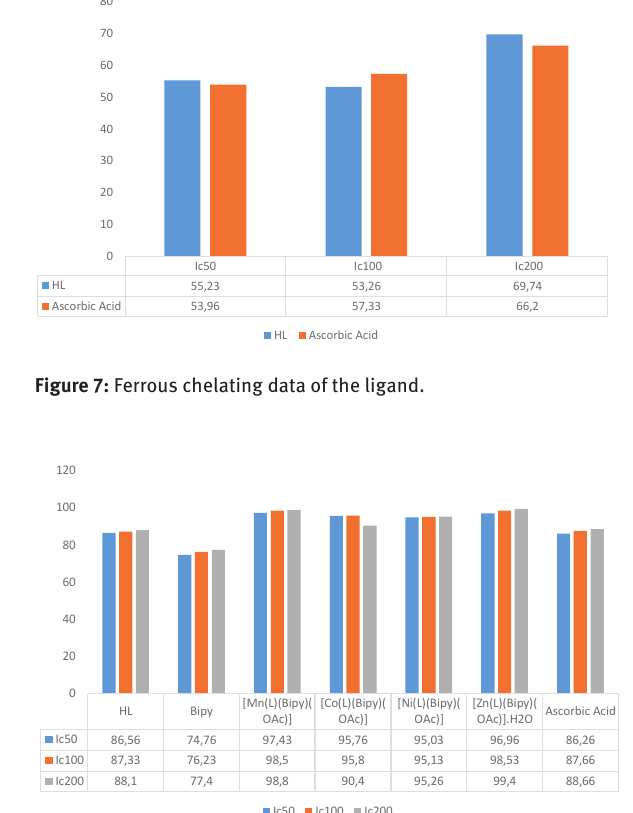
Table 6: Free binding energy(kcal/mol) of complexes and ligand.